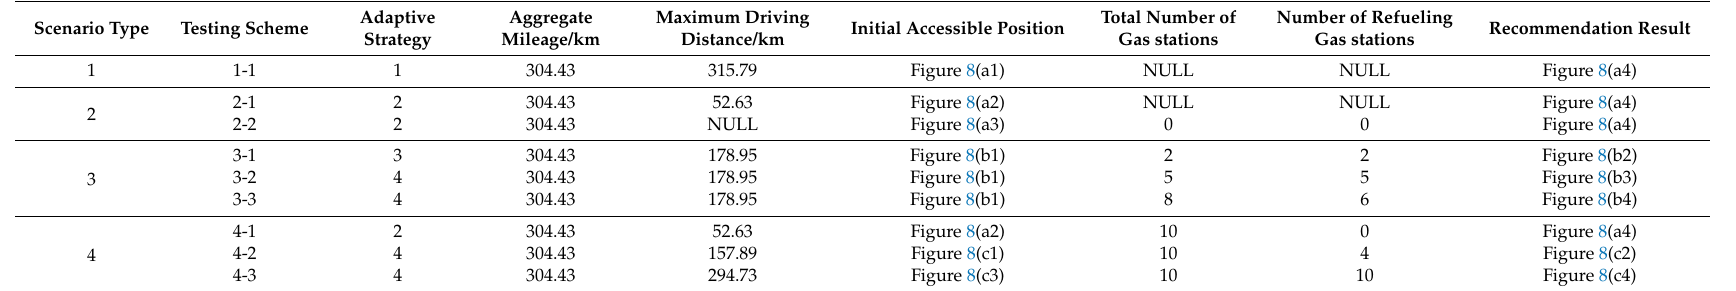
Table 5. Schemes of scenario